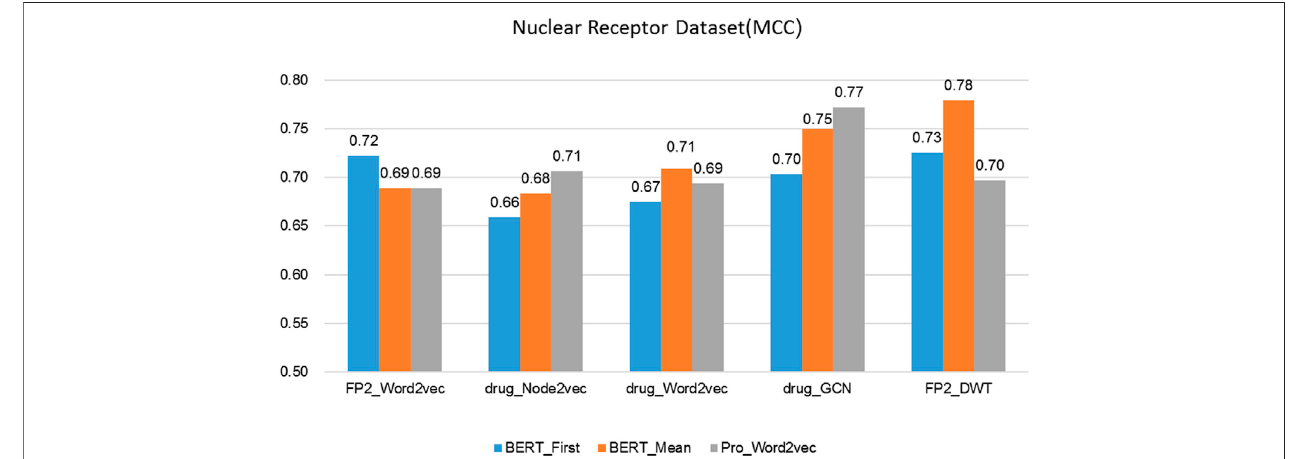
FIGURE 6 | The performance of different protein and drug descriptors on the nuclear receptors dataset.